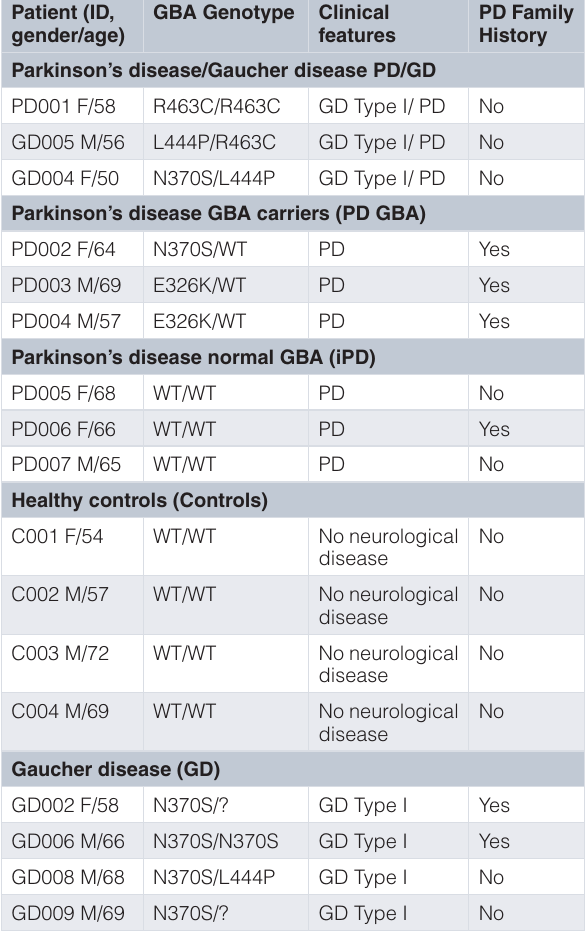
Table 1. Clinical and demographic information for the patient fibroblast lines. WT = Wildtype, (?) = Unknown genotype. Patient (ID,